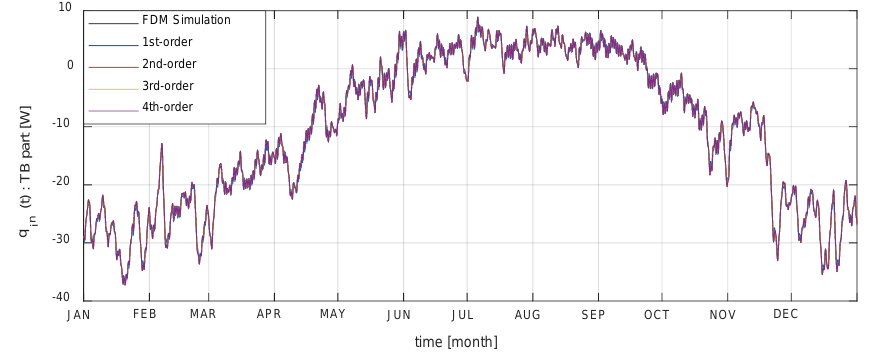
Figure 10. System response for the annual outdoor temperature.